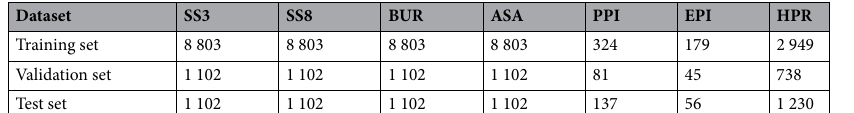
Table 2. Overview of the number of protein sequences in the training, validation and test set of the seven downstream protein structural prediction tasks. The prediction tasks secondary structure in three (SS3) and eight (SS8) classes, buried residues (BUR) and absolute solvent accessibility (ASA) are based on the same dataset. Furthermore, we included the prediction tasks protein-protein interaction interfaces (PPI), epitope interfaces (EPI) and hydrophobic patches